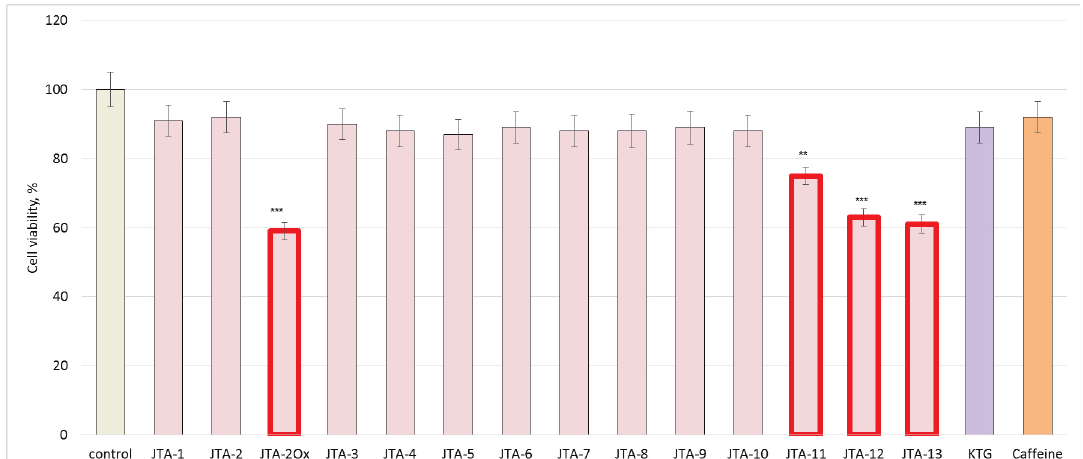
FIGURE 2 - Effects of caffeine-8-thioglycolic acid (KTG) derivatives, administered alone, on SH-SY5Y cell viability, measured by MTT-test. After 24 h of treatment with test substances cell viability is expressed as a percentage of a control (non-treated cells). Mean ± SEM (n = 6). ** P < 0.01; *** P < 0.001 – vs control.